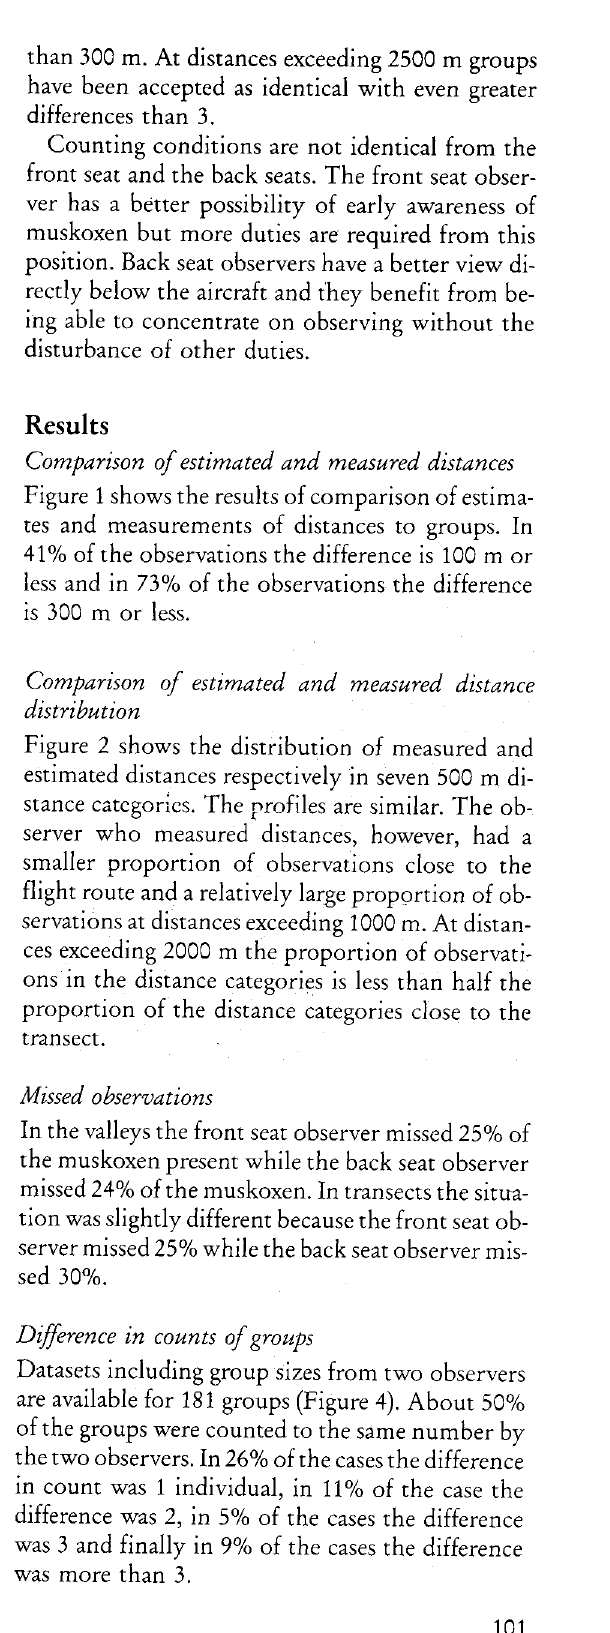
Fig. 3. Frequency distribution of distances to observed groups.